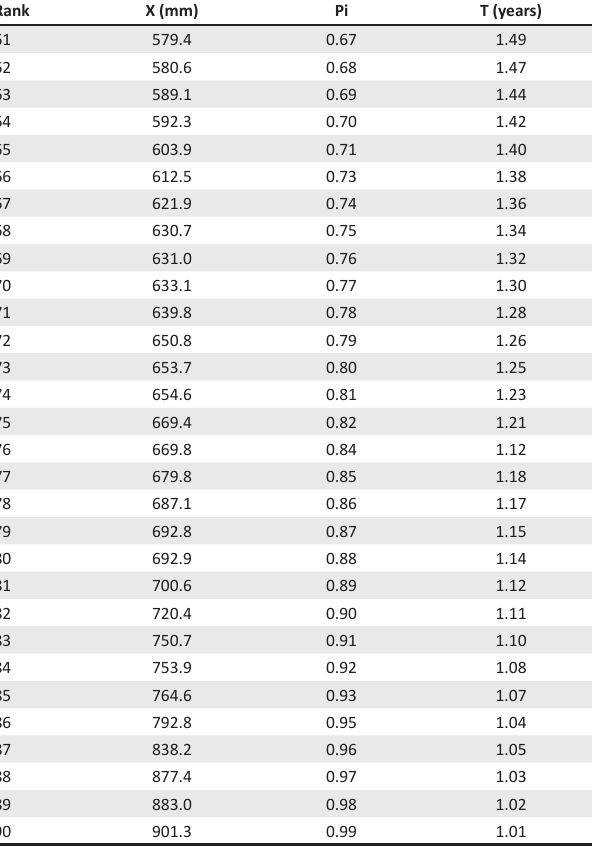
TABLE 3 (Continues...): Rainfall totals, plotting positions and return periods of maize prone to agricultural drought in the growing period of October to December in the rainfall zone